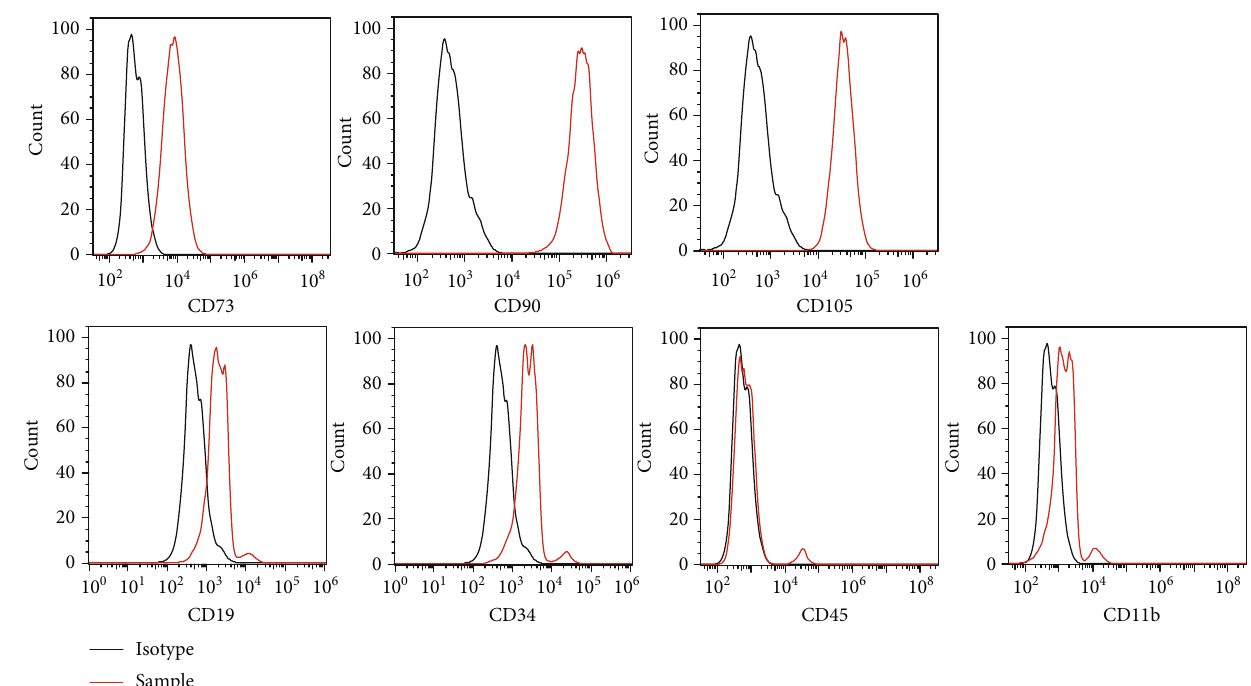
Figure 1: Phenotypes of BM-MSCs. Flow cytometry analysis of cell surface markers of untransfected BM-MSCs. The black-lined histograms indicate isotypic